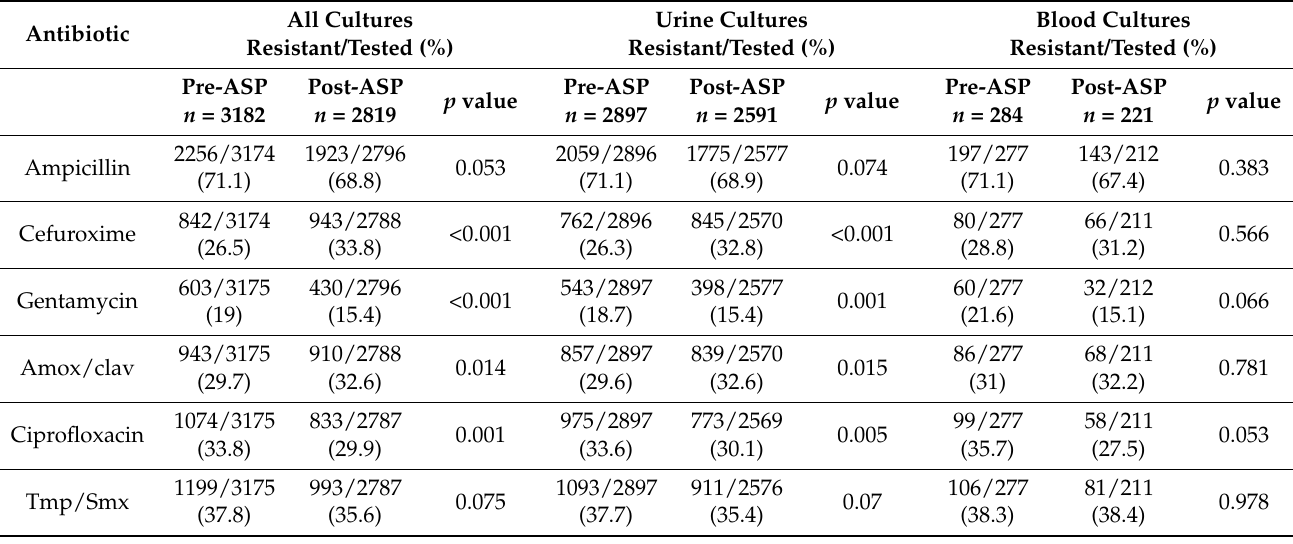
Table 2. Antibiotic resistance of E. coli in urine and blood cultures before and after ASP intervention. All Antibiotic